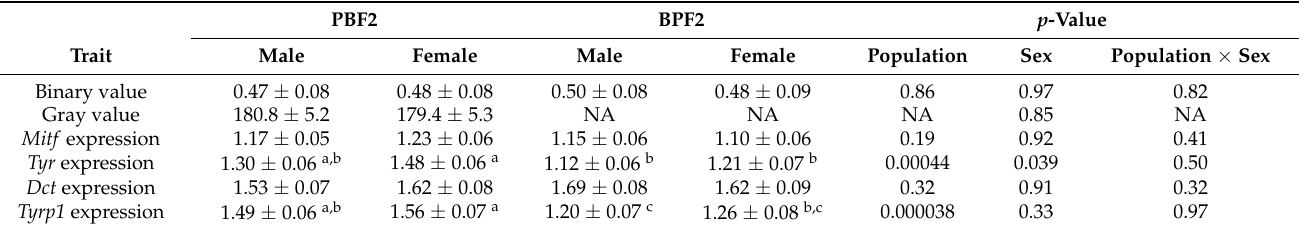
Table 2. Trait measurements in PBF2 and BPF2 populations and the effects of population and sex on the measurements.